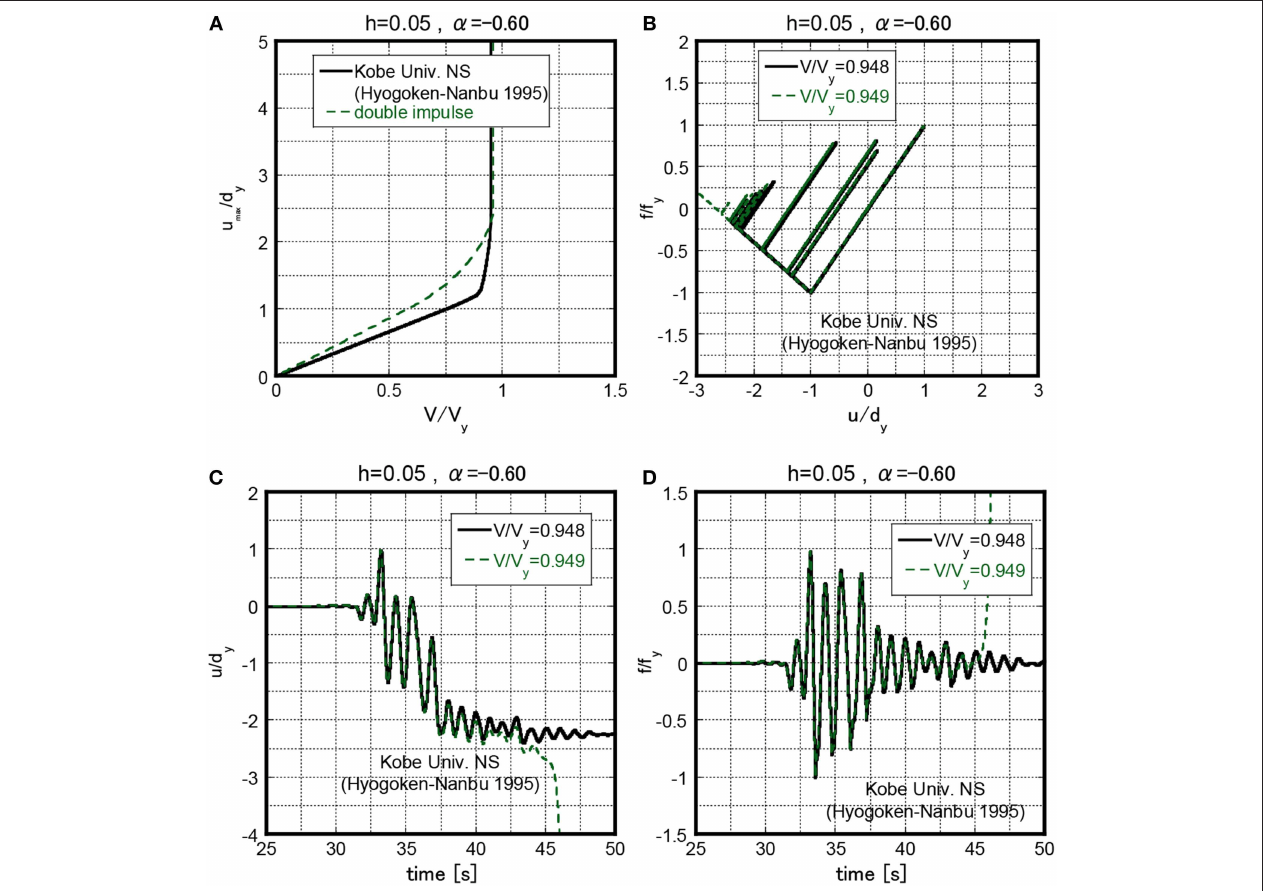
FIGURE 15 | Elastic-plastic response under Kobe University NS component of system with h ( V / V y 0.949), (A) Maximum deformation with respect to normalized input level, (B) Restoring force-deformation relation, (C) Normalized deformation time history, = (D) Normalized restoring-force time